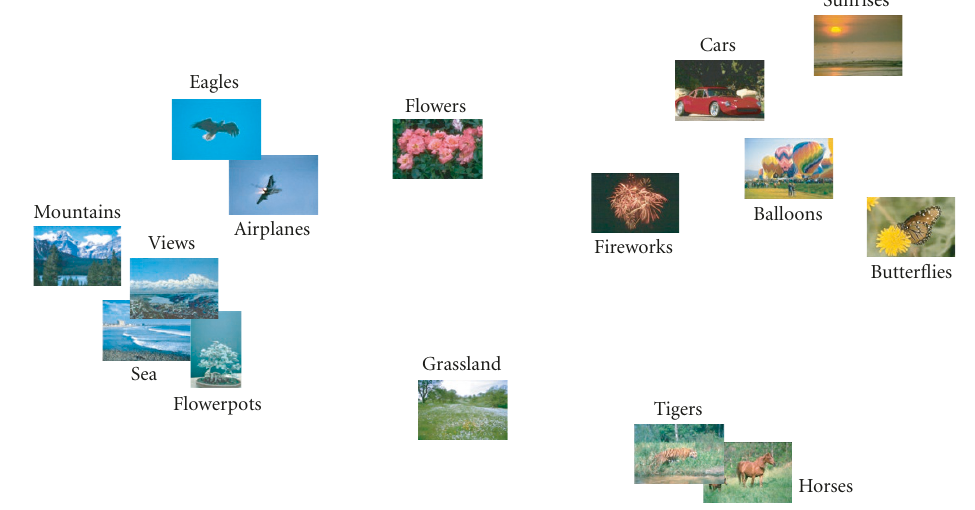
Figure 4: 2D biplot reflecting the machine perception, regarding the class prototypes.